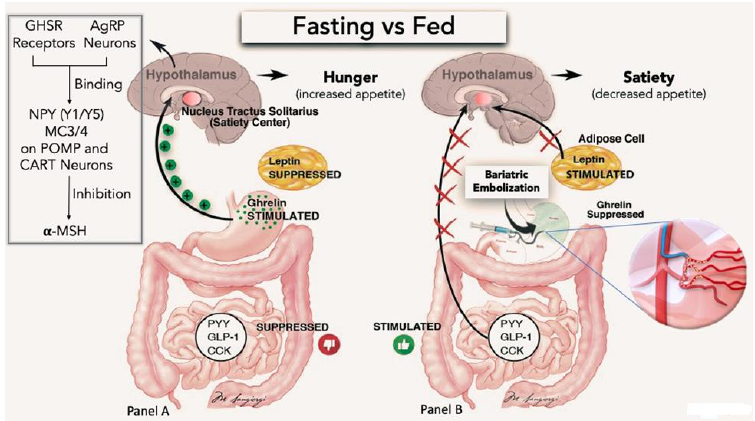
Figure 2. Hormonal changes and diagram of the ghrelin signal pathway. ( A ) The “hunger hormone” ghrelin is secreted by the gastric fundus, whereas peptide YY (PPY), cholecystokinin (CCK), and glucagon-like peptide (GLP-1) are secreted in the gut from L cells. Adipocytes produce leptin (LPT). In the fasting state, decreased food intake suppresses the release of PPY, GLP-1, CCK, and LPT, while stimulates ghrelin production from the stomach. Ghrelin binds in the hypothalamic arcuate nucleus to growth hormone secretagogue receptor (GHSR) in neuropeptide Y (NPY) and agouti-related peptide (AgRP) neu-rons. NPY and AgRP bind subsequently to NPY subtype 1 and 5 (NPH Y1/Y5) and melacortin-3 and-4 (MC3/4) receptors on proopiomelanocortin (POMP) and cocaine-amphetamine-regulated transcript neurons (CART), inhibiting the release of 𝛂 - melanocyte-stimulating hormone ( 𝛂 -MSH). By inhibiting 𝛂 -MSH, ghrelin acts to increase hunger and food intake. ( B ) BES procedure reducing ghrelin production in the stomach fundus area, mimics a fed state characterized by PYY, GLP-1, CCK, and LPT hormone increases. As a result, appetite decreases and an increase in the feeling of satiety